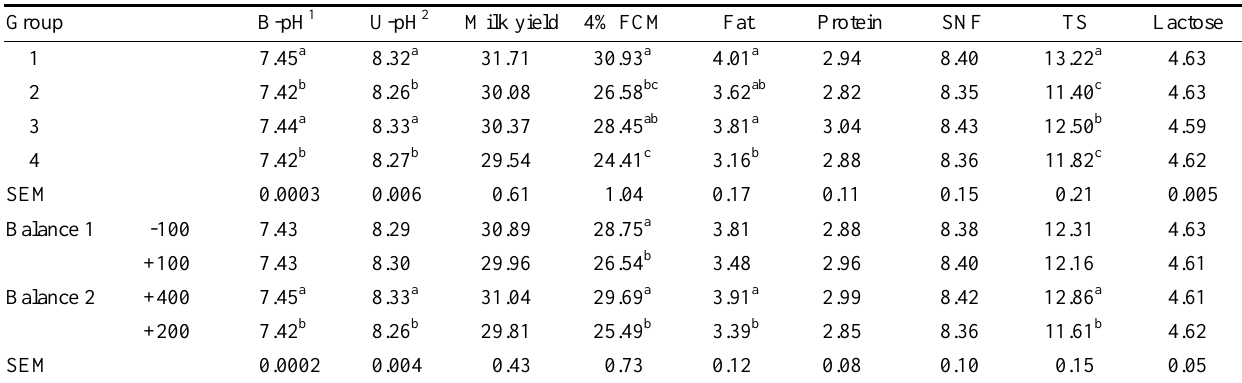
Table 6. Effect of dietary cation-anion difference on blood and urine pH, milk production and milk compositions in postpartum period